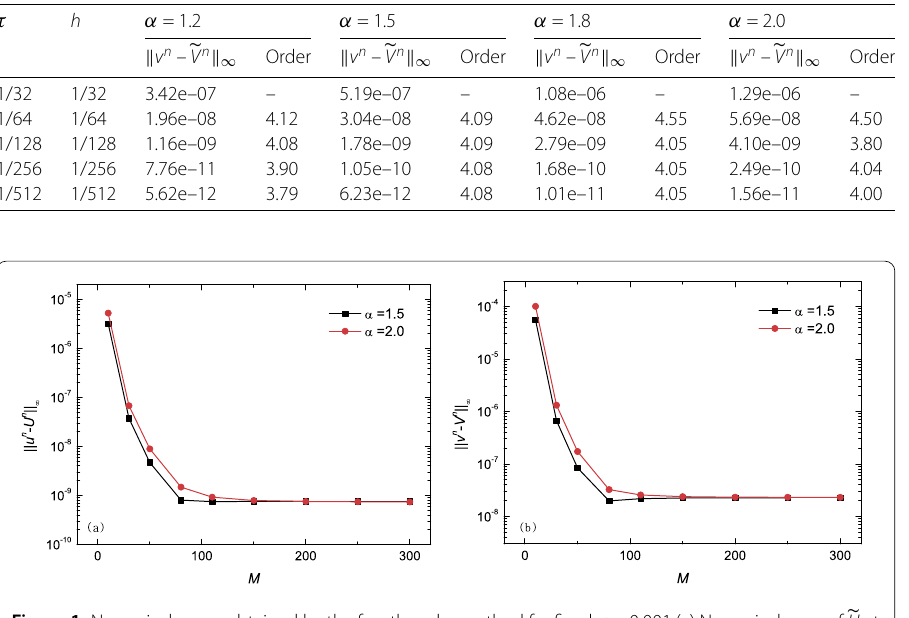
Figure 1 Numerical errors obtained by the fourth-order method for fixed τ = 0.001.(a) Numerical error of (cid:24) U at T = 1;(b) Numerical error of (cid:24) V at T =